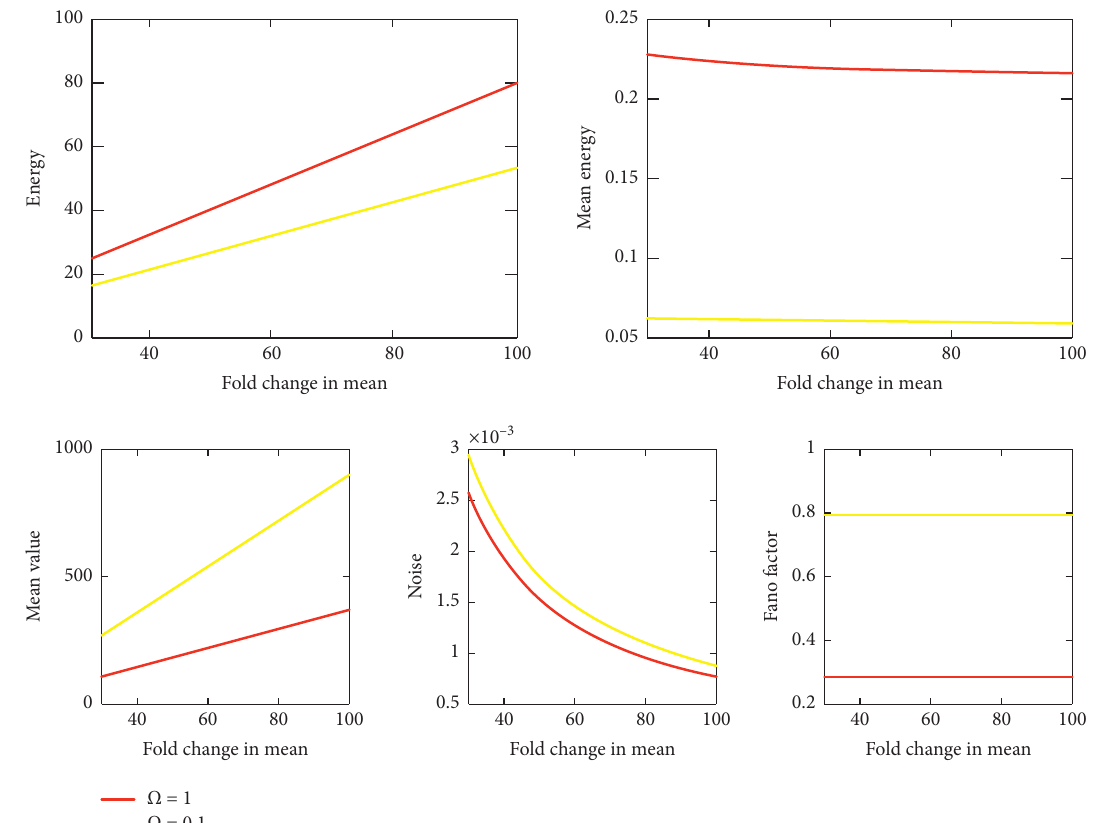
Figure 7: Free energy consumption of dual promotion and its effect on gene expression (including mean, noise, and Fano factor); parameter values are set as k on A � 0 . 27 ,k off A � 0 . 23, η